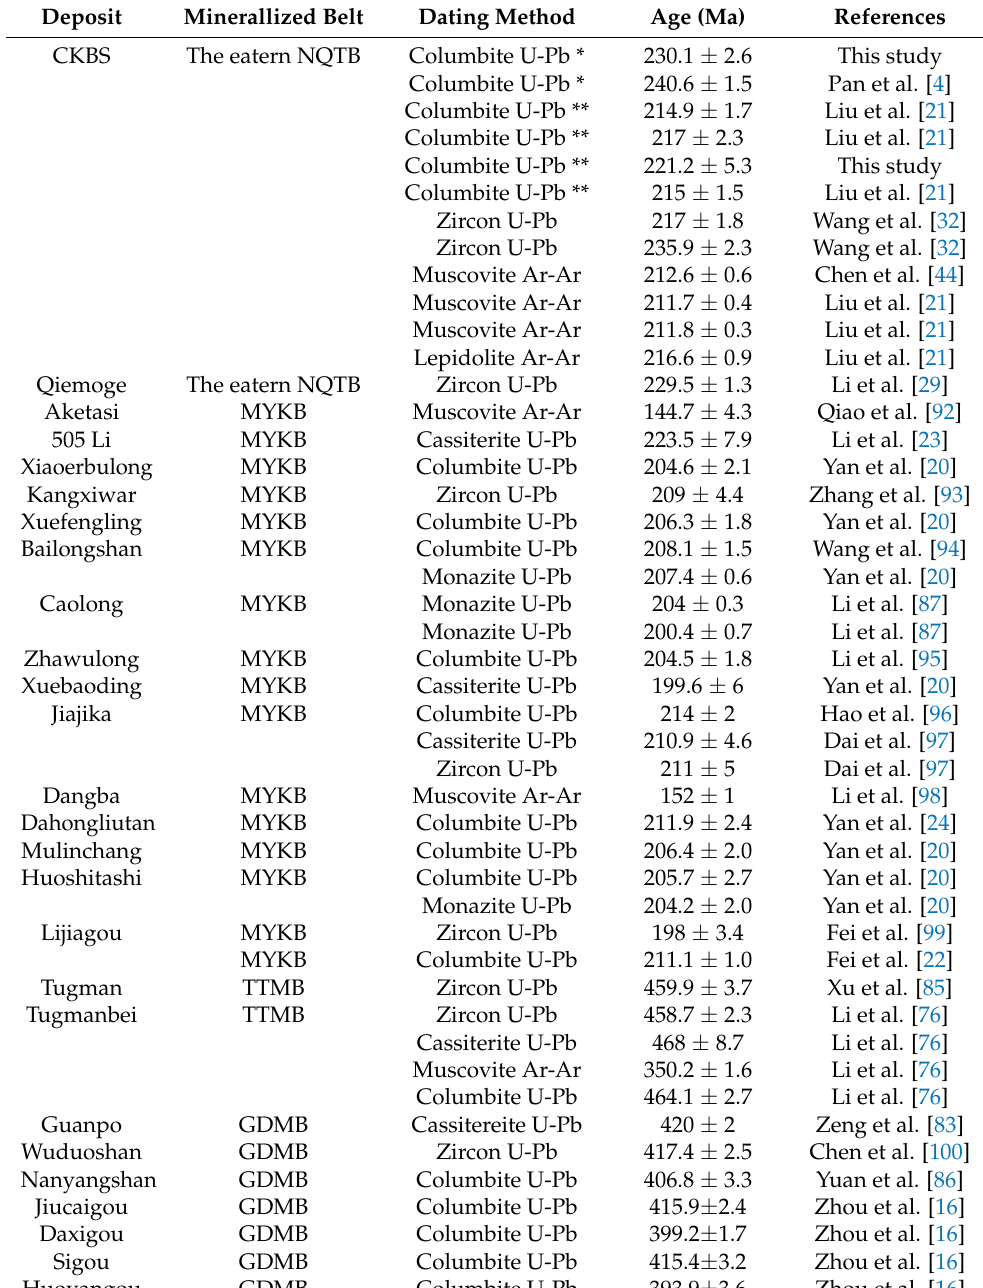
Table 3. The formation ages revealed by various dating methods for pegmatite-type rare-metal deposits in the TTMB, MYKB, GDMB and the eastern